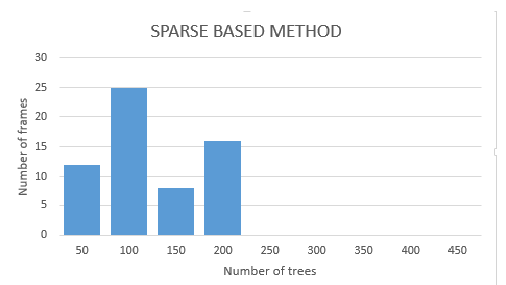
Figure 12 Graph Depicting Number of Frames Vs Number of Trees from Sparse Based Method The figure 12 showing the graph of number of frames vs number of trees counted through sparse method on 60 frames.